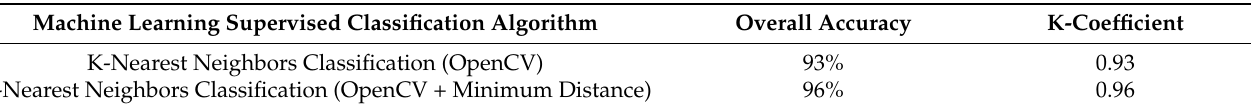
Table 9. Comparison of